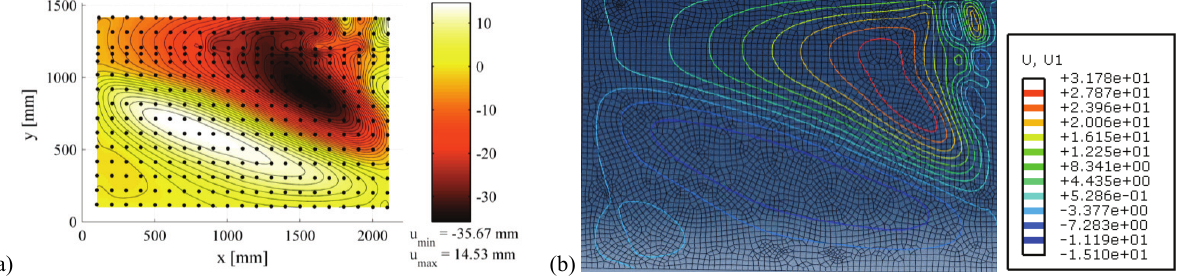
Fig. 9. Displacements perpendicular to central plane of web in panel SC (test SC), at maximum vertical displacement U2 = 70 mm: